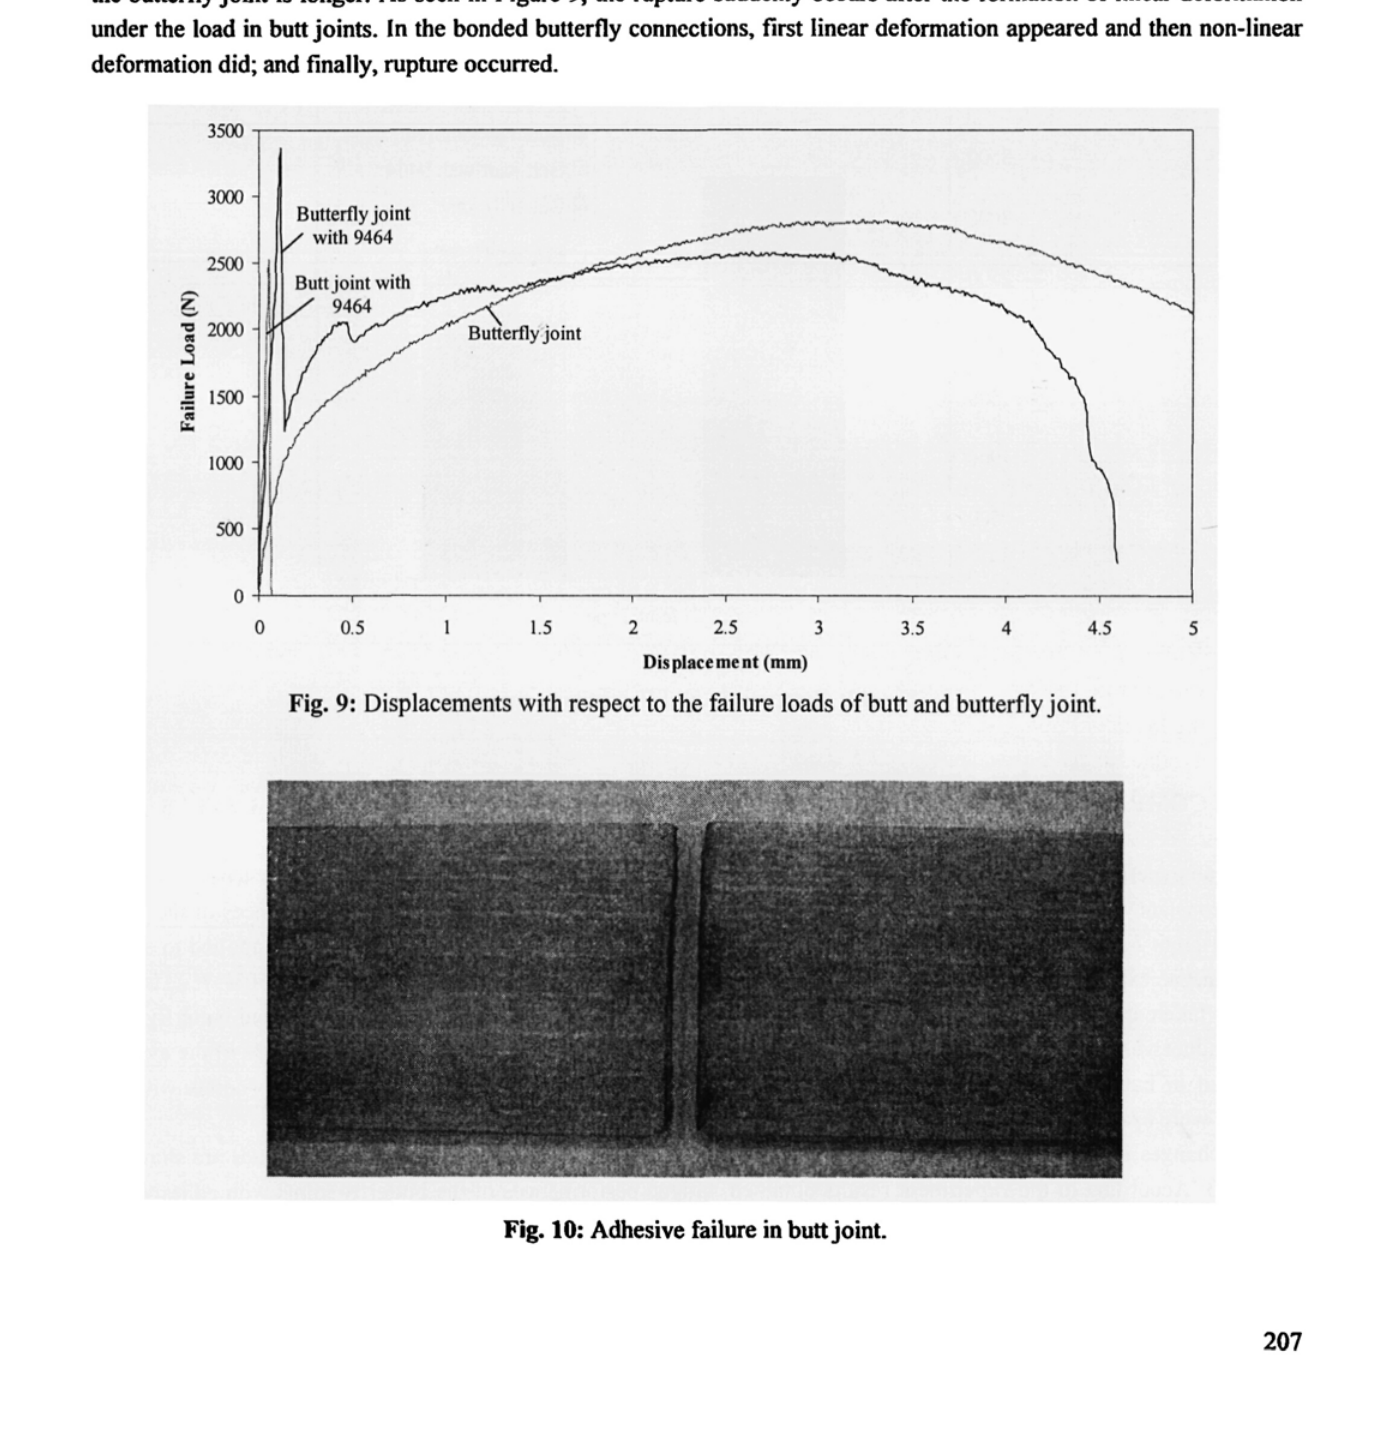
Fig. 9: Displacements with respect to the failure loads of butt and butterfly joint.